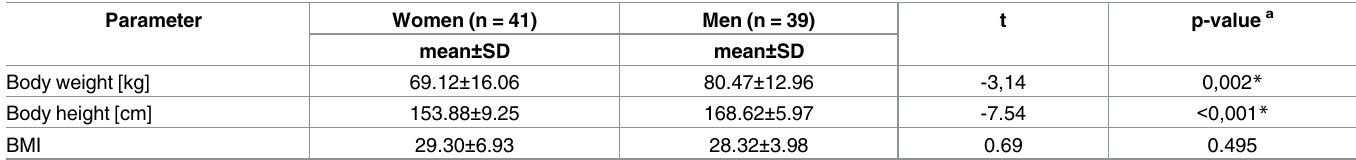
Table 1. Somatic parameters of the study